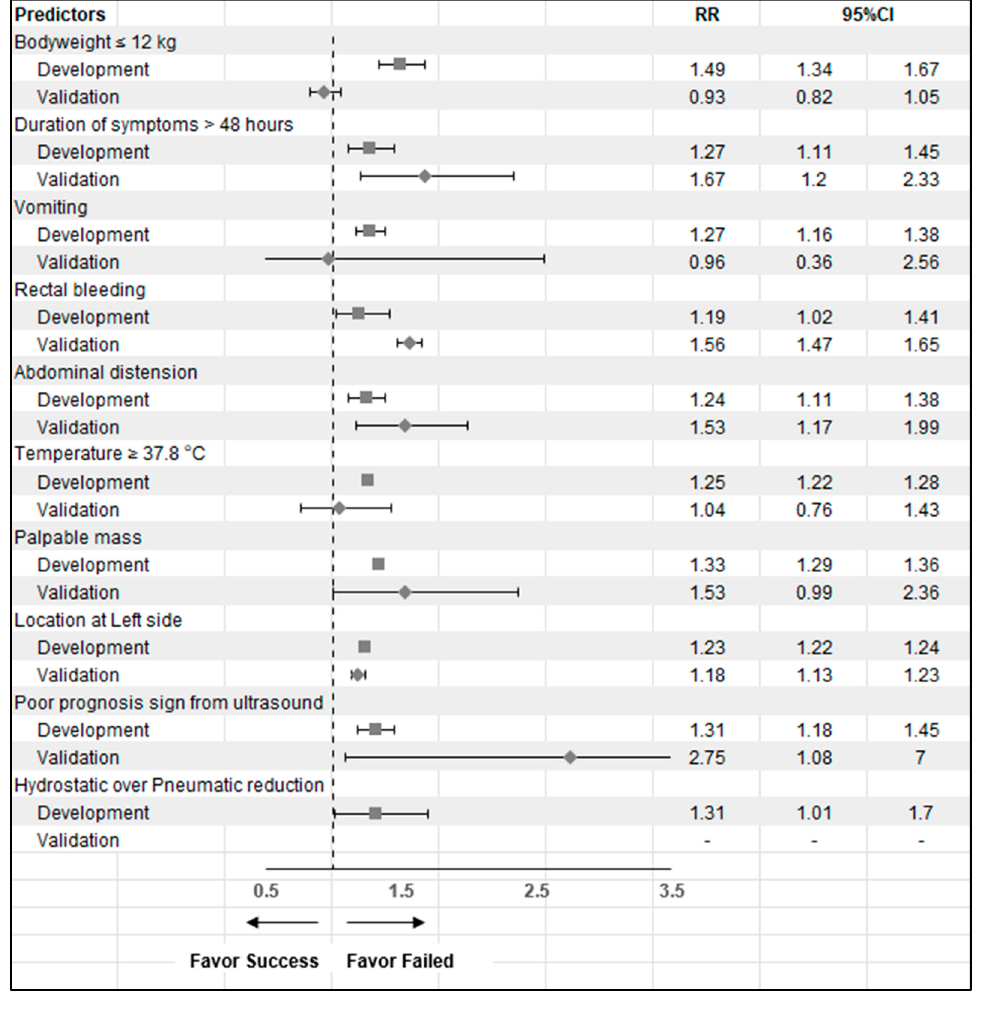
In the validation dataset, the sensitivity, specificity, likelihood ratio, and predictive